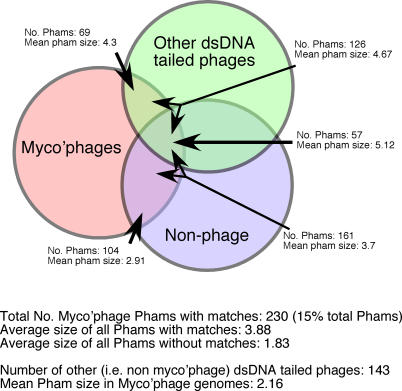
Relationships between Mycobacteriophage Phams and Previously Sequenced ProteinsThe number and size of mycobacteriophage phamilies with sequence similarity to nonmycobacteriophage genes are shown. The numbers of Phams shared by mycobacteriophages, other phages, and nonphage genomes are shown, along with the average pham size, defined as the number of mycobacteriophage genomes containing at least one member of that phamily. The red circle represents mycobacteriophage genomes, the green circle represents all dsDNA phage genomes other than the mycobacteriophages, and the blue circle represents all nonphage genomes. The number of phams shared between these groups and the mean mycobacteriophages pham size of those phams are shown, with arrows indicating whether they are shared by mycobacteriophages (red circle), nonmycobacteriophage phage genomes (green circle), or nonphage genomes (blue circle).